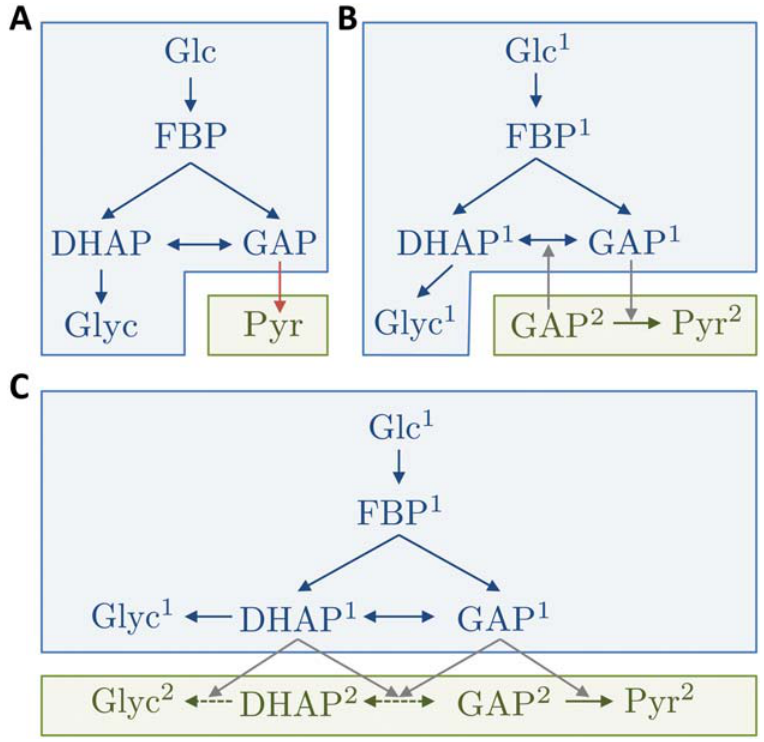
Fig 1. Modularization, non-cascaded and cascaded layering of a simplified model of the glycolytic pathway (see [46] p.88 ff.). Nodes represent metabolites, coloured arrows reactions, and grey arrows information transfer. Intermediate metabolites and cofactors are omitted, and several enzymatic reactions are merged. Modules (A) or layers (B and C) are delineated by blue and green boxes. In each panel the blue subnetwork corresponds to the single functional subsystem Glc ! Glyc of glycolysis, where the conversion from GAP into Pyr has been removed. All panels consider the integration of the Glc ! Glyc pathway (blue arrows) with the missing (merged) reaction GAP ! Pyr. A) Modularization of the pathway [18 – 26]. Modules are typically defined by non-overlapping sets of species, and can be interconnected by mass flow (red arrow, representing the load of the new species) and information transfer. Here, there is mass flow when the blue module is integrated with the green module, leading to retroactive effects [4]. The combined dynamics will be in feedback, and hence both modules must be considered simultaneously. B) Non-cascaded layering [16, 17]. Layers are defined by non-overlapping sets of reactions, while species may take part in multiple layers; species ’ affiliation to layers is indicated in superscript. The dynamics of species in multiple layers are summed (e.g. GAP( t ) = GAP 1 ( t ) + GAP 2 ( t ) + GAP( t = 0)). Layers are interconnected only by information transfer (grey arrows) and their models are not modified when combined. However, as in the modular case, the layers are in feedback and must be considered simultaneously. C) Cascaded layering of the pathway, as introduced in this article. By allowing the layers to overlap in ‘ altered reactions ’ (green broken arrows) as well as species, the layers become cascaded as information (grey arrows) is only transferred in one direction. The states of the green layer directly capture the incremental effect of extending the isolated Glc ! Glyc pathway with the additional (merged) reaction GAP ! Pyr. Since the information transfer between the layers is cascaded, they can be numerically integrated and analysed